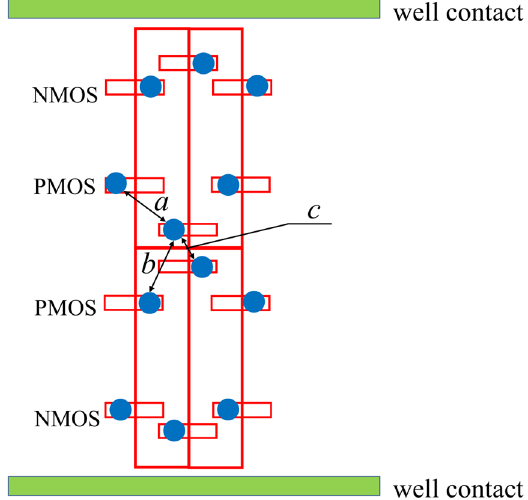
Figure 8. Schematic of sensitive areas (blue dots) within four adjacent cells.